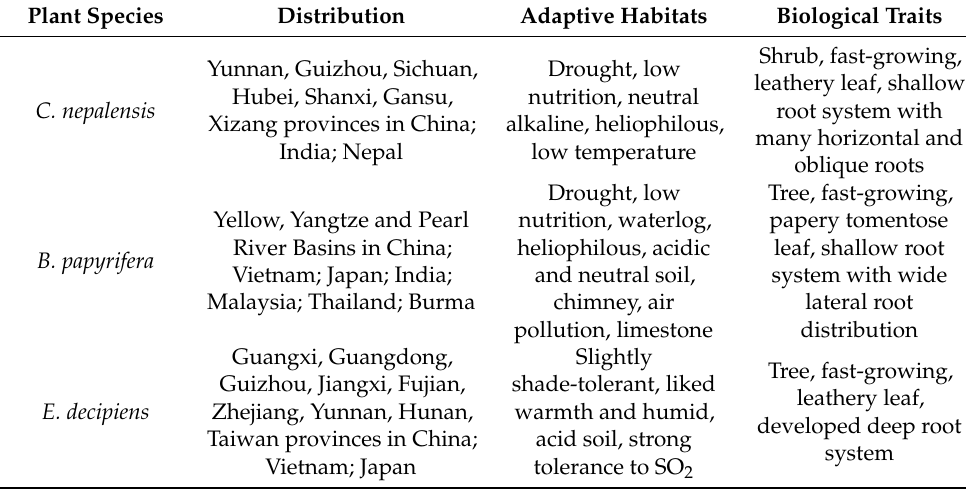
Table 1. Comparison between C.nepalensis, B. papyrifera, and E. decipiens . Plant